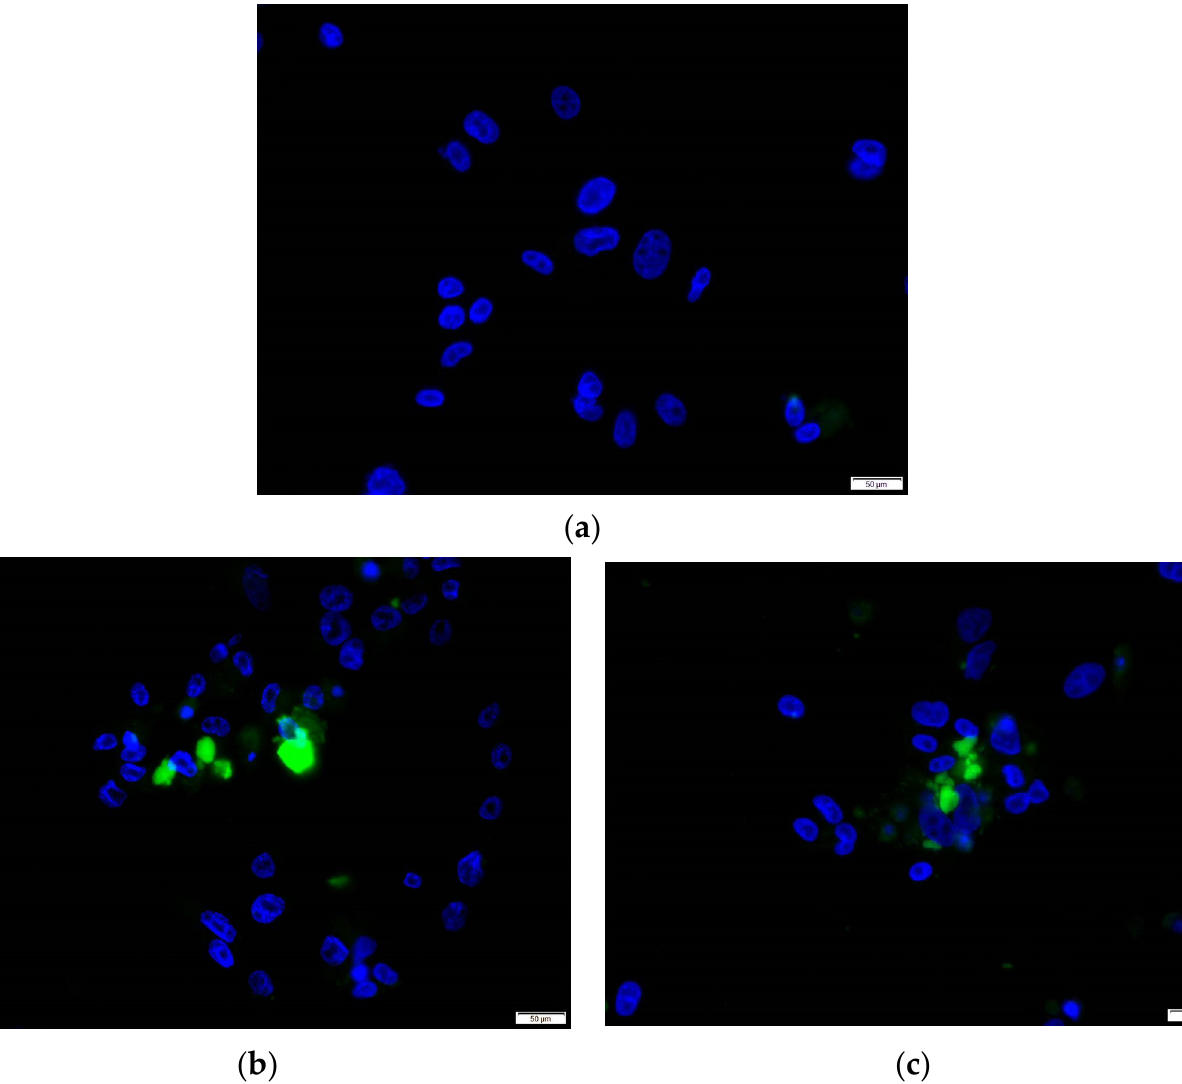
Figure 3. Immunofluorescence antibody staining of ( a ) uninfected PLC/PRF/5 cells, ( b ) HEV-A genotype 4 (HEV-A4)-infected cells, and ( c ) HEV-C genotype 1 (HEV-C1)-infected cells. Nuclei were counterstained with DAPI. Furthermore, we used HEV-A4 cell culture supernatant stock (1 × 10 5 copies/mL) to infect naïve PLC/PRF/5 cells and maintained them for over 42 dpi at an average viral load of 5 × 10 4 copies/mL, confirming that there was viable virus released into supernatant (Supplementary Figure S1). This confirms that PLC/PRF/5 cells were productively infected.